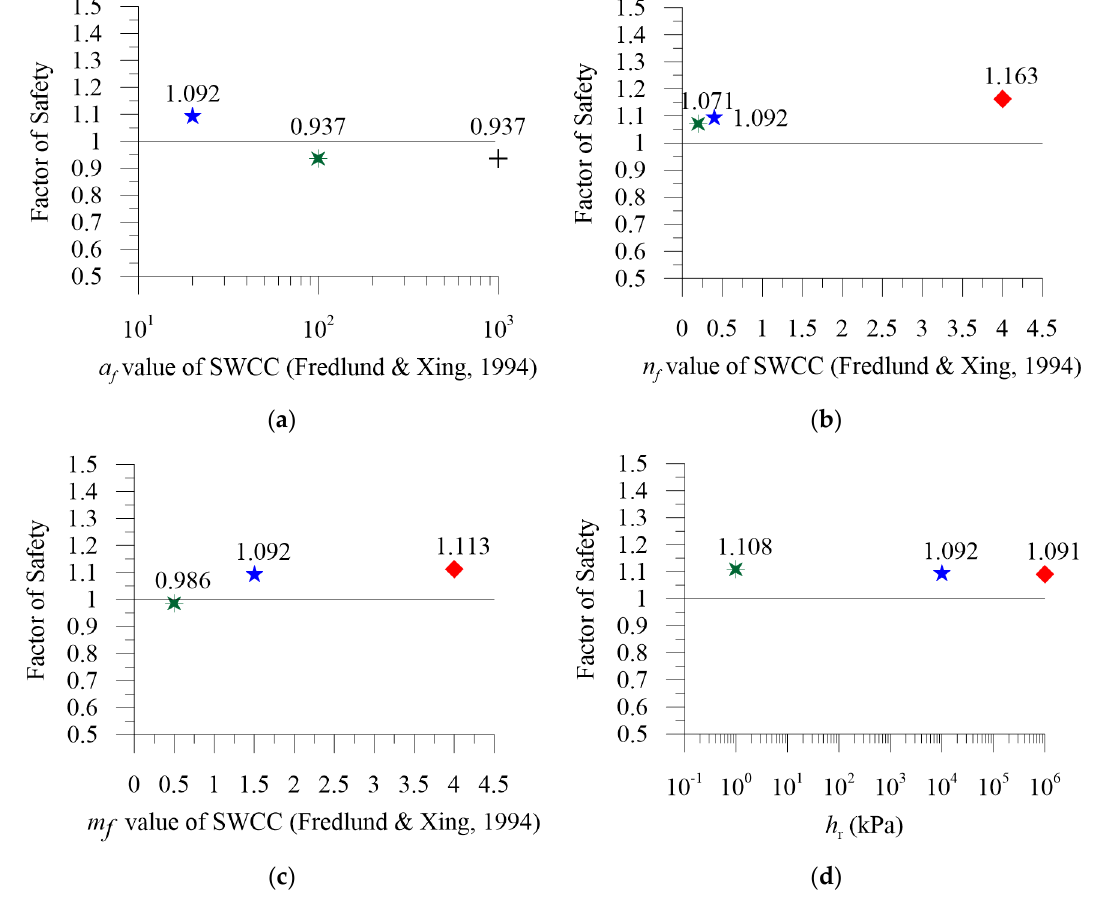
Figure 8. Factor of Safety variation versus Fredlund and Xing parameters ( a ) a f ; ( b ) n f ; ( c ) m f ; ( d ) h r .